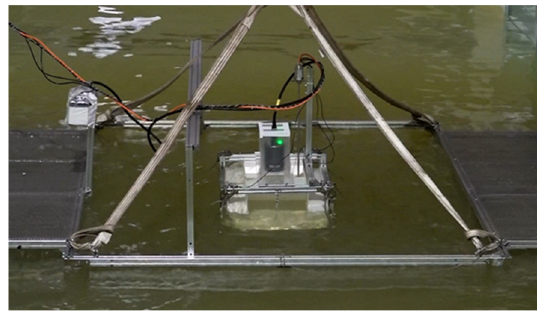
Figure 10. The wave energy extraction system in an experimental flume.